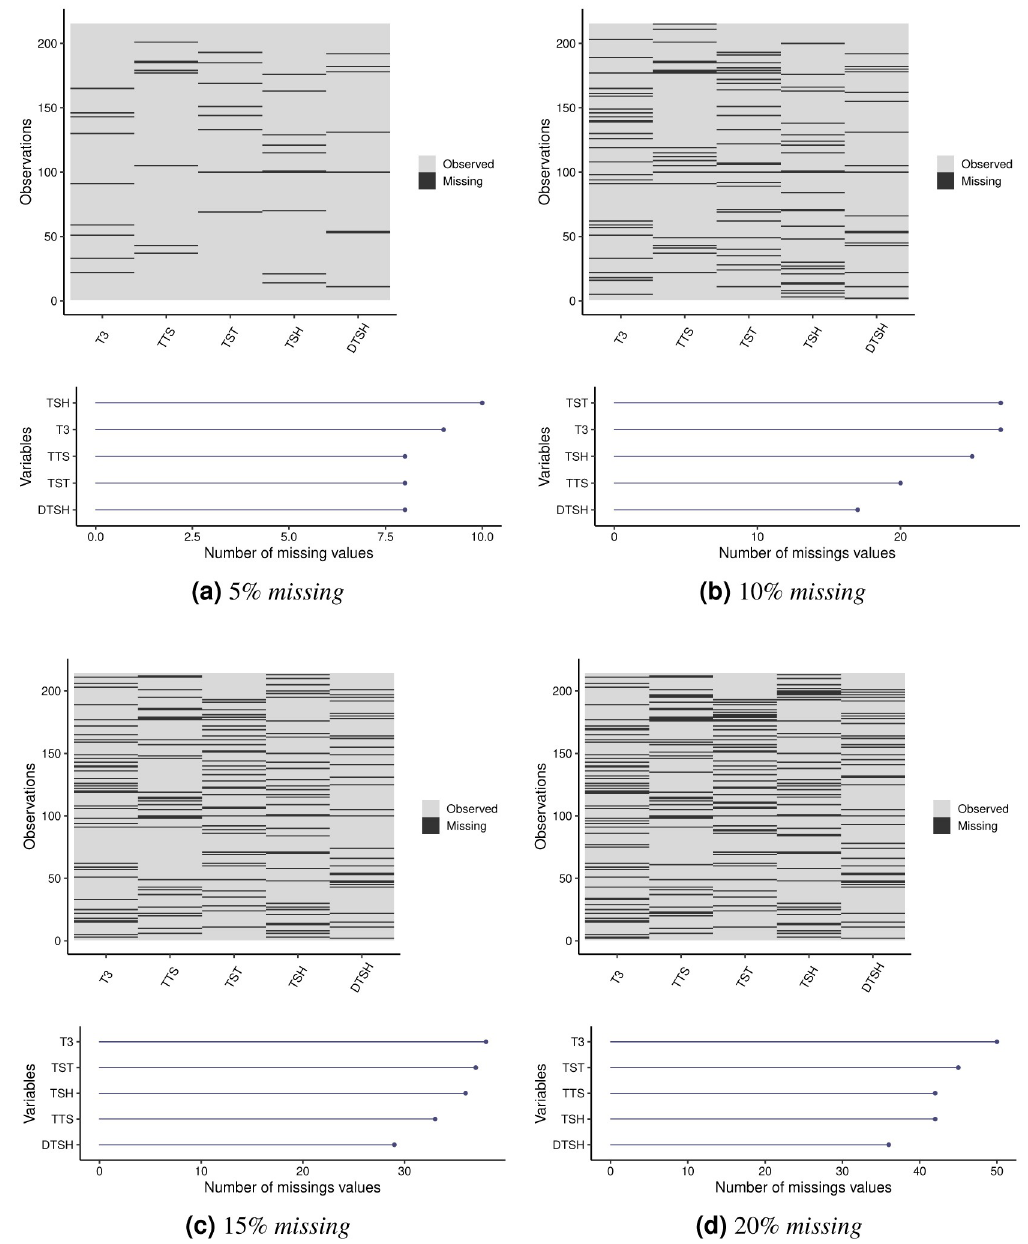
Fig 6. Graphs of missing value patterns and frequencies per variable for the Thyroid Gland dataset. ( a ) 5% missing . ( b ) 10% missing . ( c ) 15% missing . ( d ) 20% missing